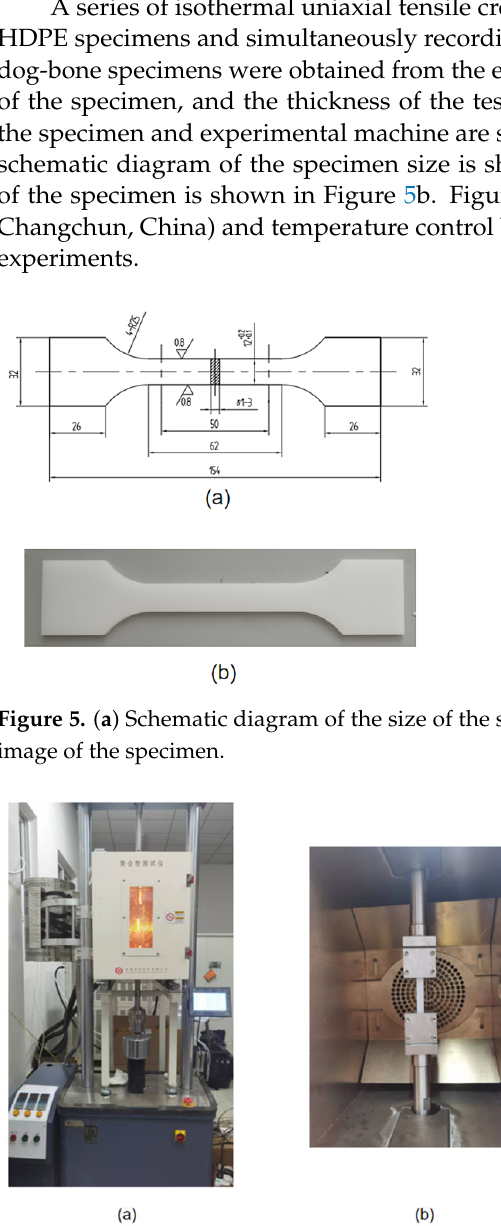
Figure 4. The three creep stages of the polymers.